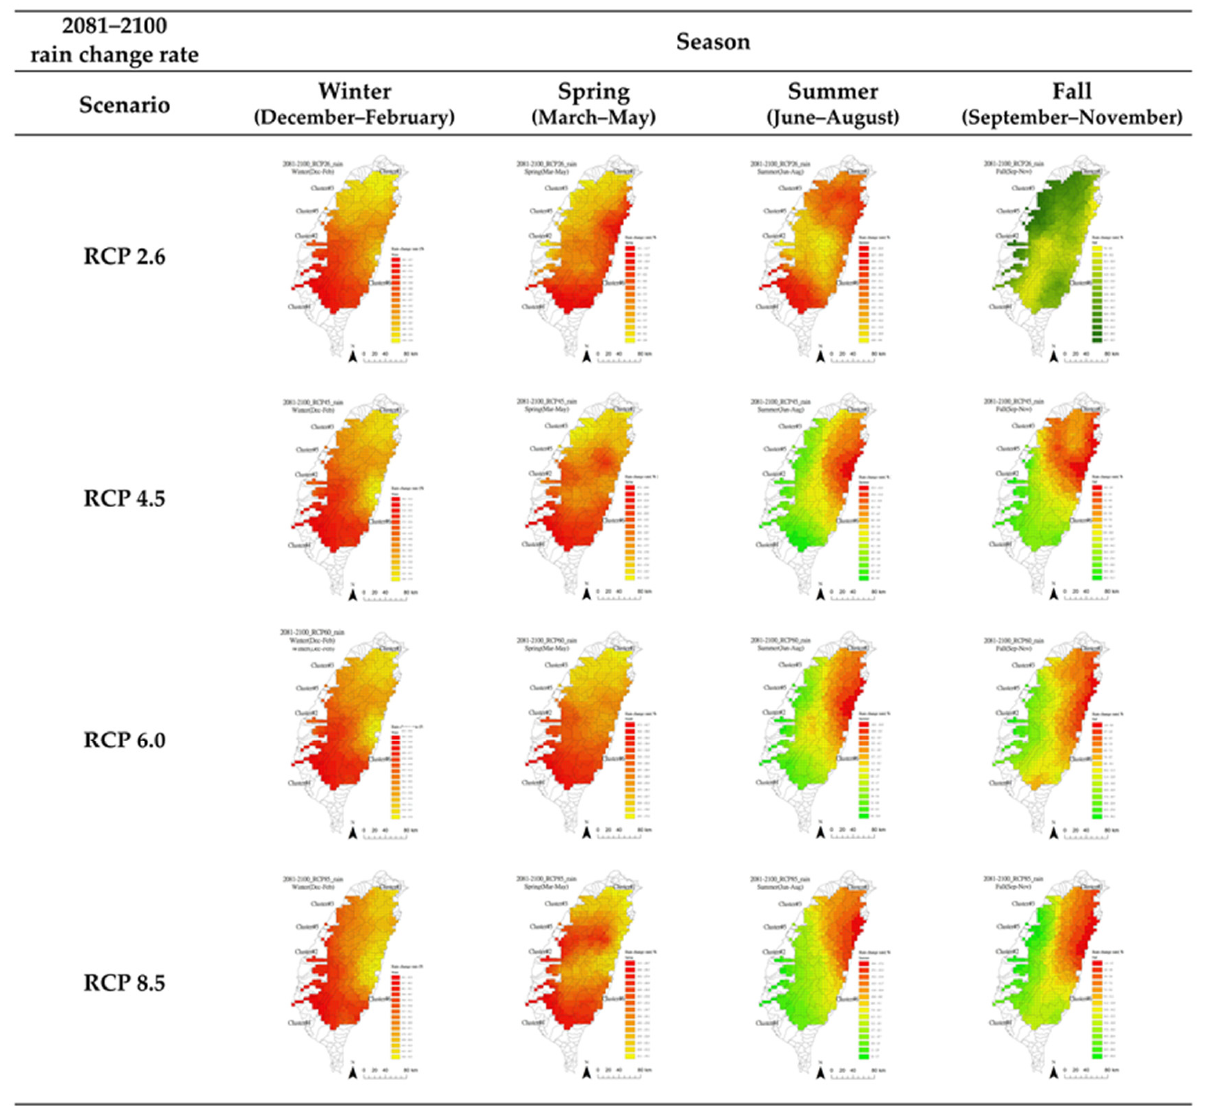
Figure A8. Spatial distribution of rain change rate from 2081–2100 for four seasons under different climate change scenar- ios.